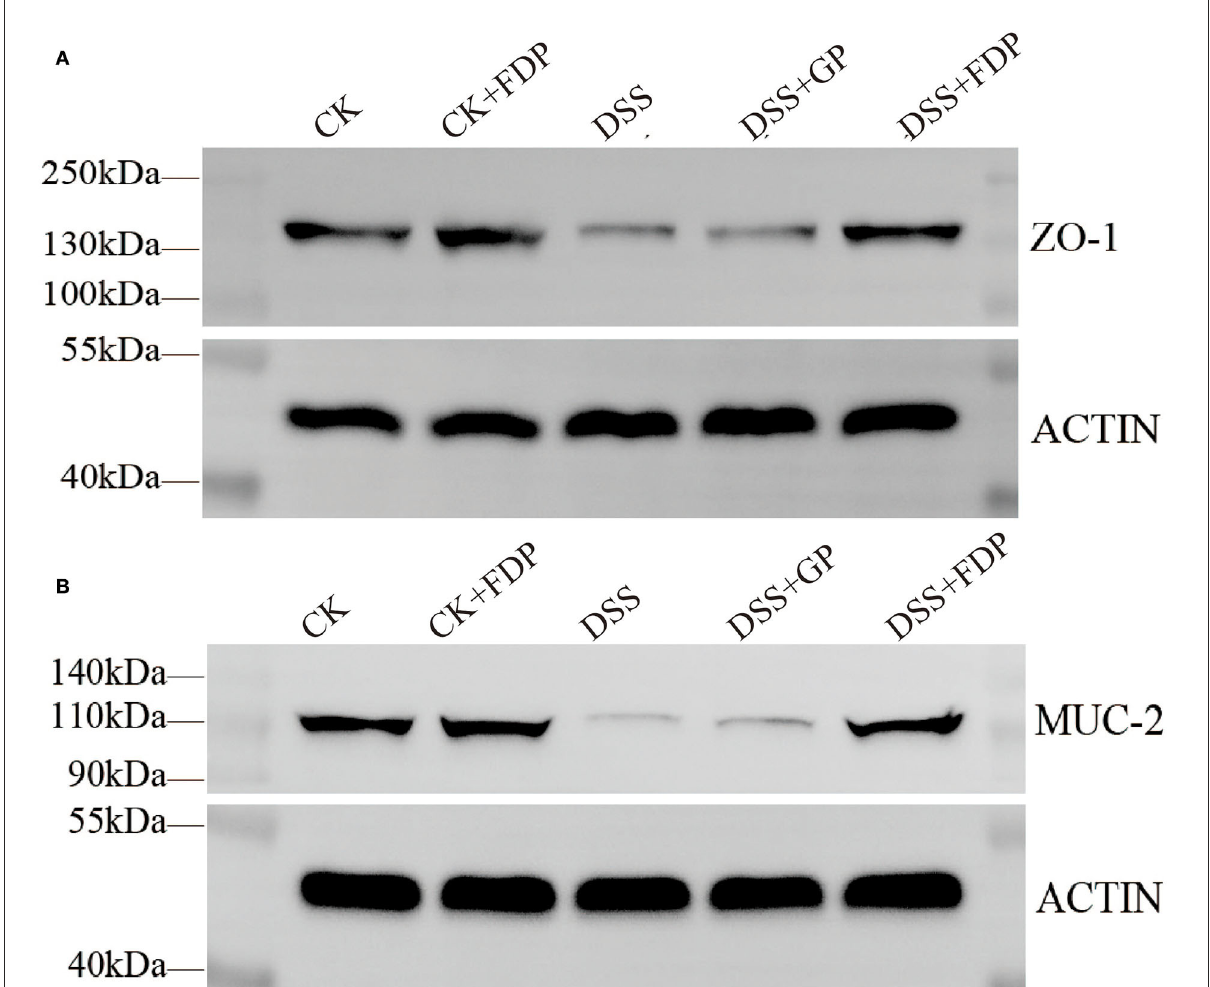
FIGURE2 Western blot analysis of tight junction proteins. Zonula occludens − 1 (ZO-1) (A) and Mucin 2 (MUC-2) (B) from mice colon tissues. CK, control check. CK + FDP, control check and drink FEMPs freely. DSS + FDW, DSS and drink water freely. DSS + GP, DSS and gavage FEMPs. DSS + FDP, DSS and drink FEMPs